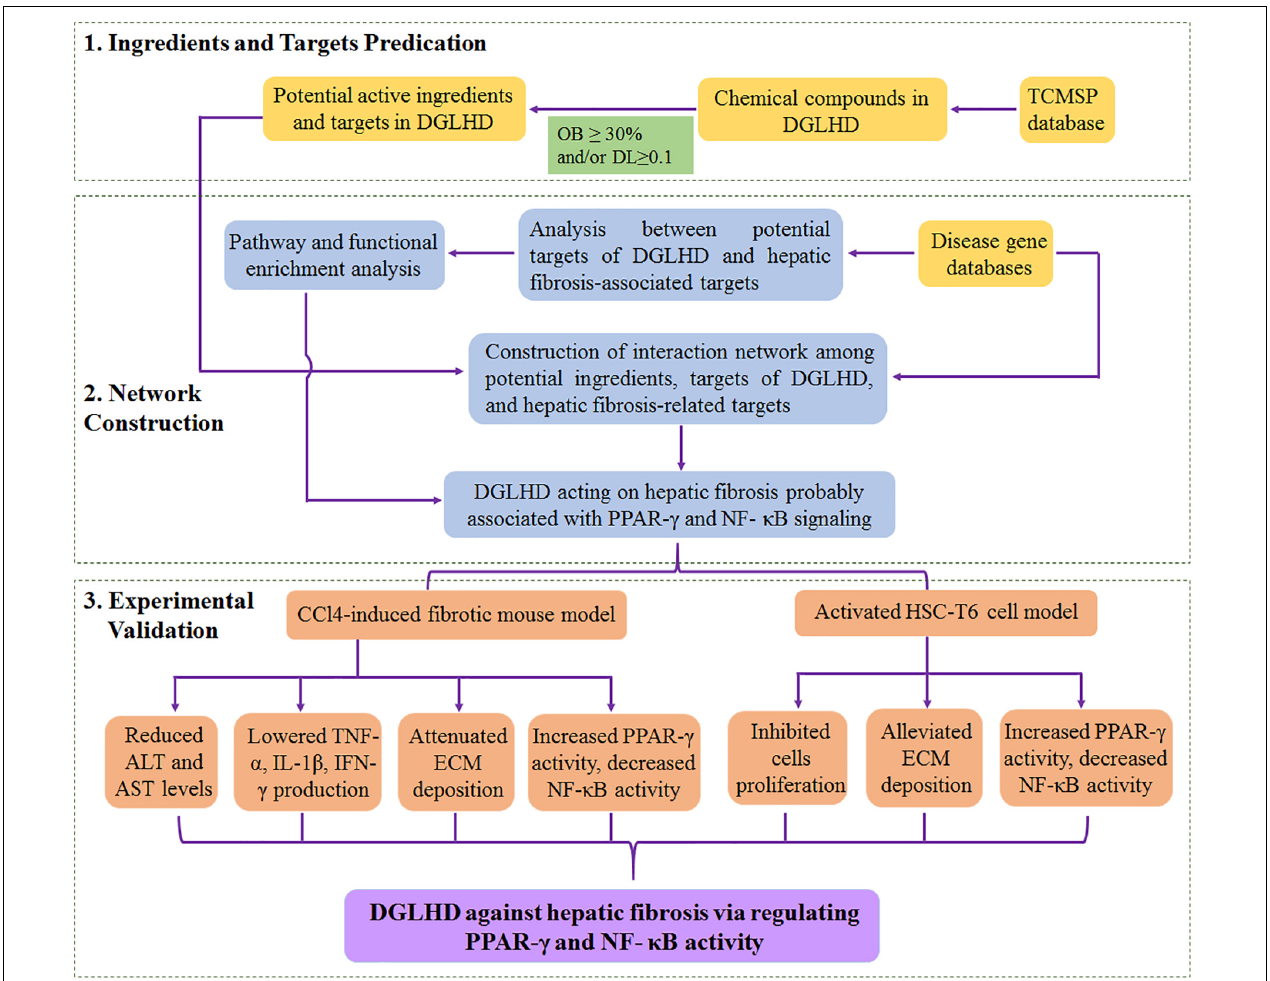
FIGURE 8 | The overview of systematic strategies for discovering the mechanisms of DGLHD acting on hepatic